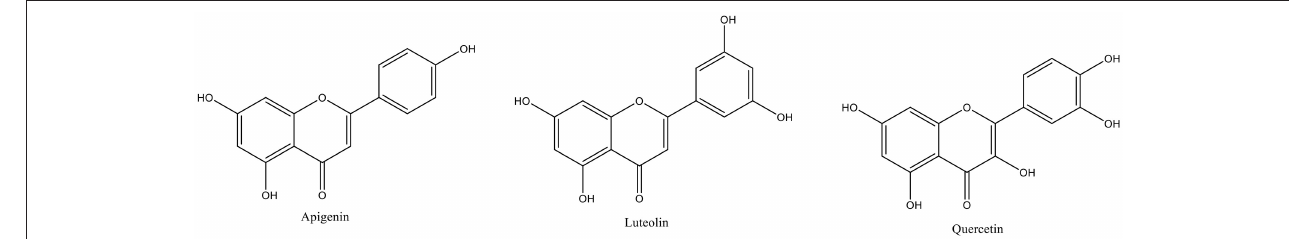
FIGURE 1 | Chemical structure of apigenin, luteolin and quercetin.